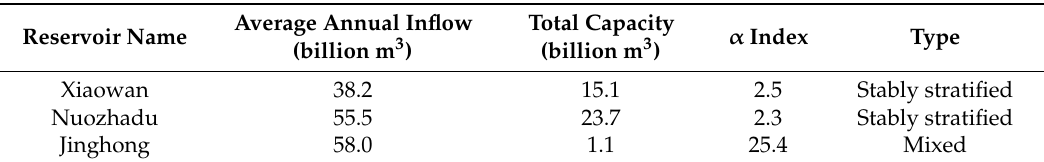
Table 3. The α index of three major reservoirs along the middle and lower reaches of the Lancang River and their thermal structure type according to the